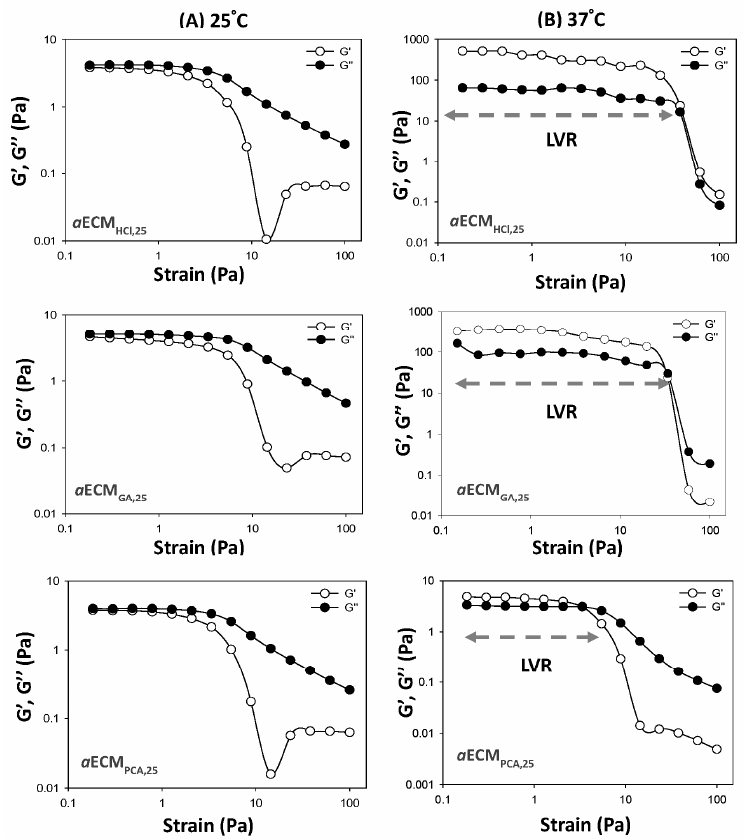
Figure 2. Rheological analysis of a ECM HCl,25 , a ECM GA,25 and a ECM PCA,25 at 25 ( A ) and 37 ◦ C ( B